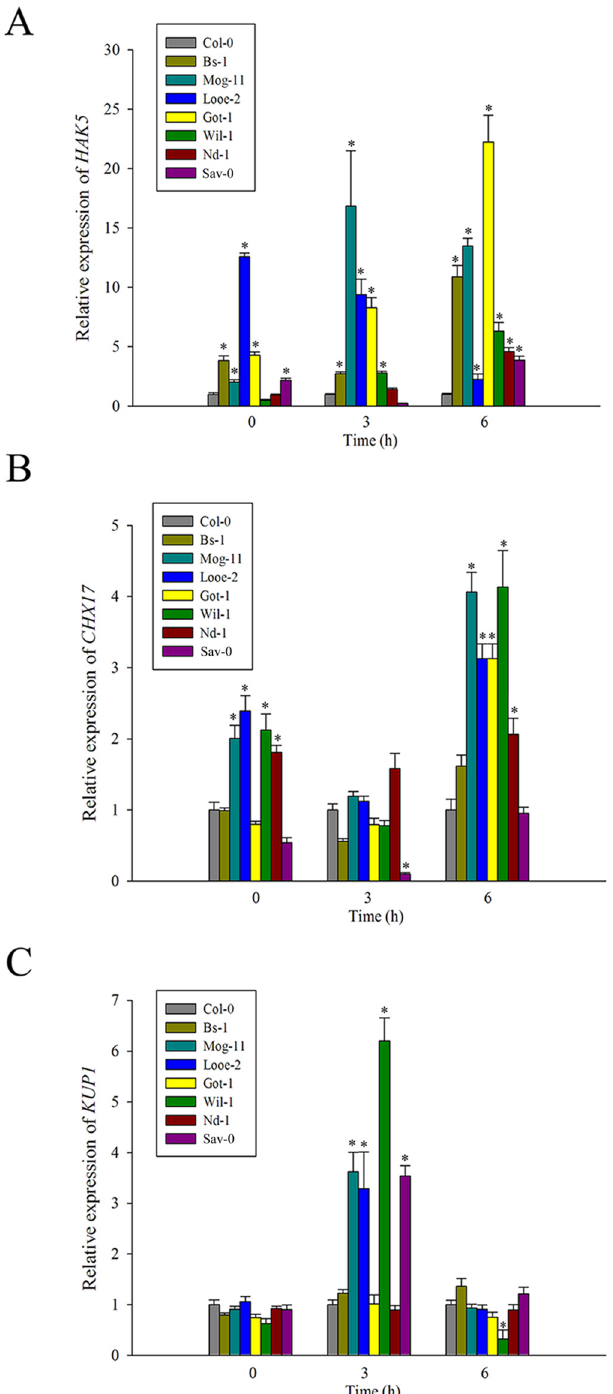
Fig 3. Expression analysis of genes related to K + transport by qRT-PCR. The transcript levels of (A) HAK5 , (B) CHX17 and (C) KUP1 in Col-0 and the selected accessions exposed to 100 mM NaCl for 0, 3 and 6 h. Values given as mean ± SE ( n = 3). Significant differences from Col-0 accession at the same time point are indicated by * or ** ( P < 0.05, P < 0.01).